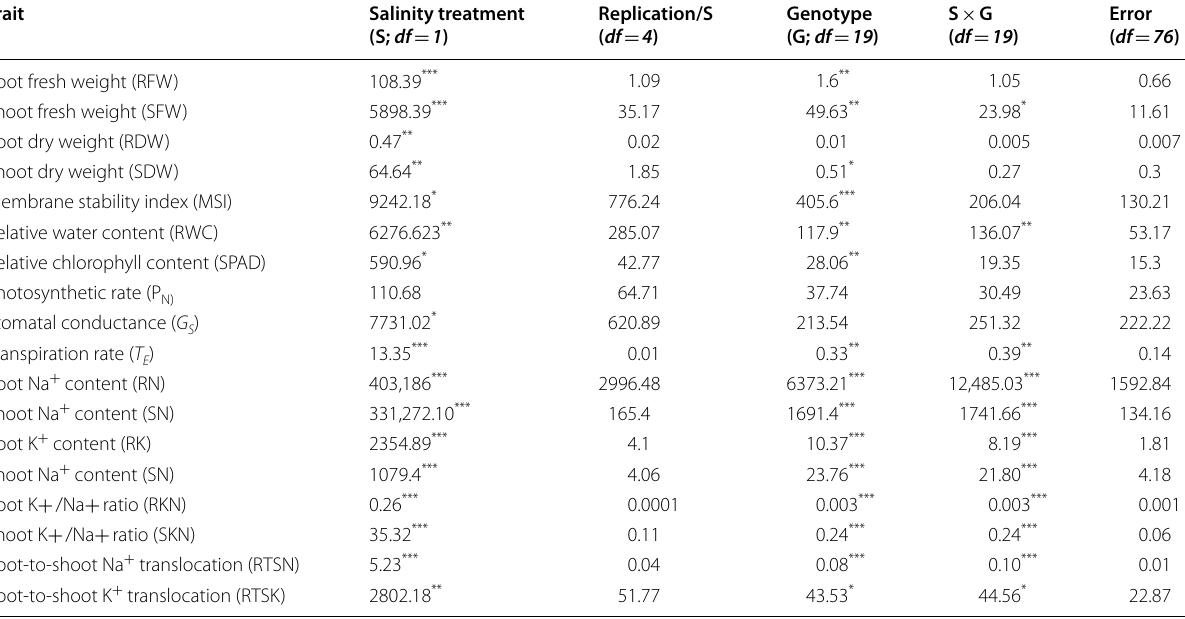
* , P < 0.05; **, P < 0.01; ***, P <